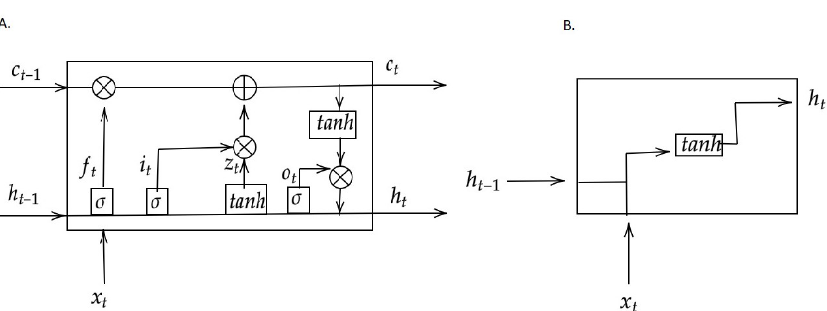
Figure 7. ( A ) LSTM unit diagram, ( B ) regular RNN unit. In an RNN unit, all input data is used for output. However, in an LSTM unit, a set of gates is used to control the information in memory and decide how long and how much information may be